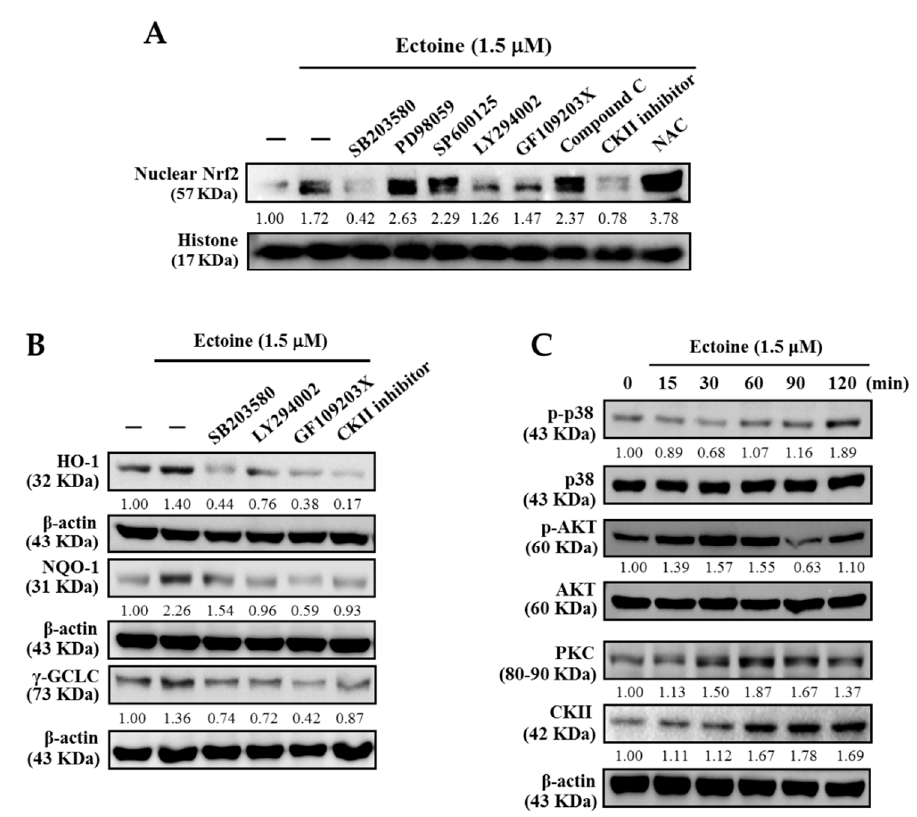
Figure 6. Ectoine mediated the activation of nuclear Nrf2 through p38, AKT, PKC, and CKII signaling pathways in HaCaT cells. ( A ) Cells were pre-treated with p38 inhibitor (SB203580, 20 μ M), ERK inhibitor (PD98059, 30 μ M), JNK inhibitor (SP600125, 25 μ M), PI3K/AKT inhibitor (LY294002, 30 μ M), PKC inhibitor (GF109203X, 2.5 μ M), AMPK inhibitor (compound C, 10 μ M), Casein kinase II inhibitor